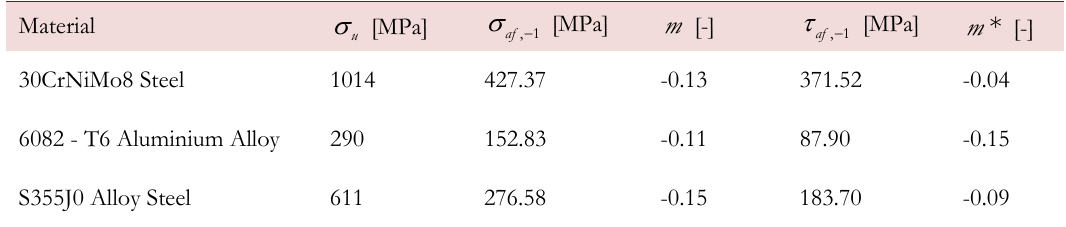
Table 1: Static and fatigue properties for each examined